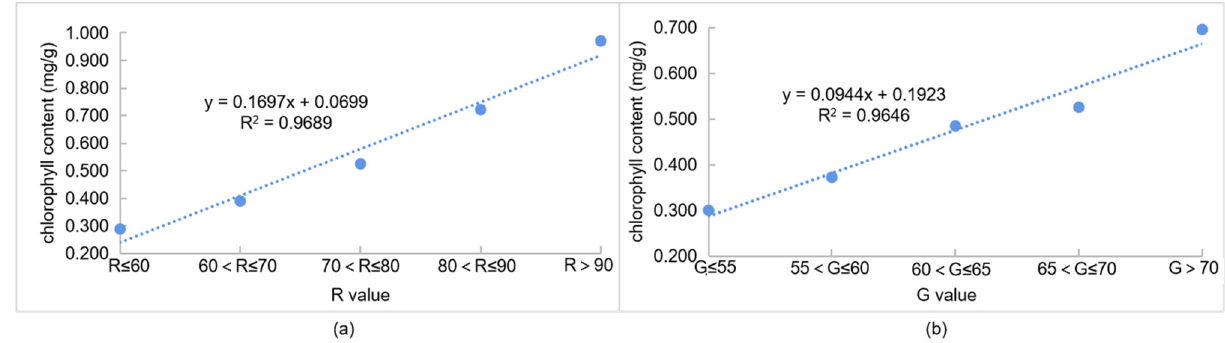
Figure 8. The linear relationships between the R value ( a ) and G value ( b ) and chlorophyll content. 3.3. Relationship between Seed Vigor and Chlorophyll Content of Astragalus Seeds The chlorophyll contents of different Astragalus seeds could be predicted based on the R and G values. In order to further demonstrate the relationship between the vitality of Astragalus seeds and the chlorophyll content, we conducted germination tests of Astragalus seeds with known chlorophyll content and grouped them based on the R values and G values. The results are given in Table 4. The proportion of high-quality seeds of seeds with R > 80 was significantly lower than that of seeds with R ≤ 80. The germination percentage, hard-seed percentage, high-quality seed percentage, abnormal seedling percentage and mildew percentage of seeds with R > 90 were significantly lower than those with R ≤ 90,